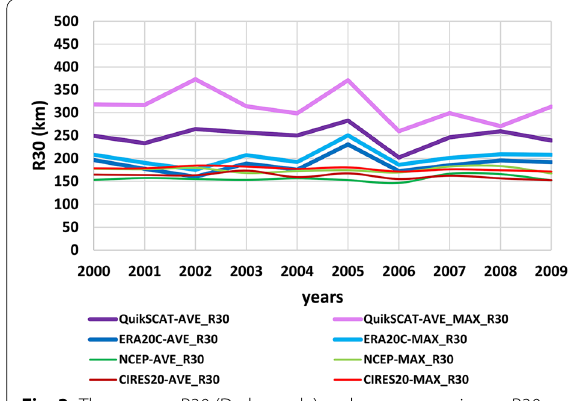
Fig. 3 The average R30 (Dark purple) and average maximum R30 (Light purple) of QuikSCAT and reanalysis experiments for NCEP (Green), ERA20C (Blue), and CIRES20 (Red) from 2000 to 2009, respectively